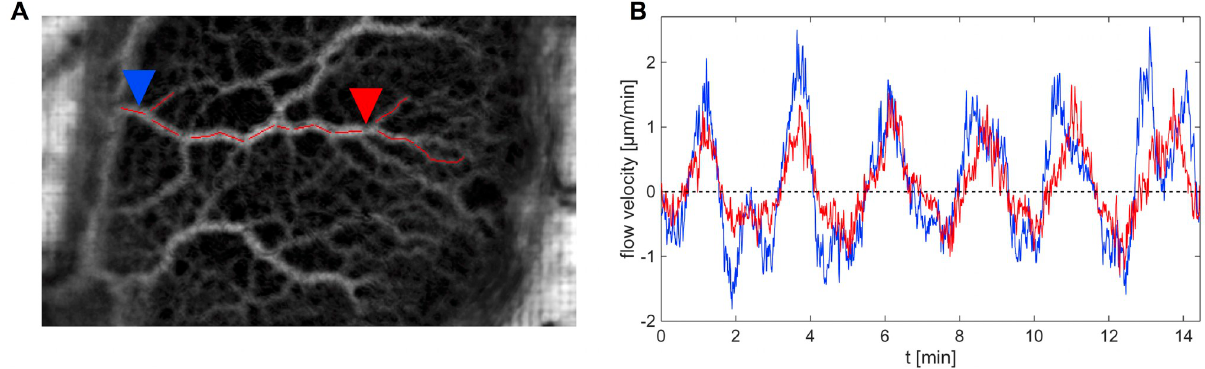
Fig 15. Flow velocity at different positions along a vein. A) Time series (standard deviation) of a mesoplasmodium with a major vein highlighted in red. Blue and red arrowheads denote positions at which internal flow was measured. B) Flow velocity at the two indictated positons in A along a forward moving